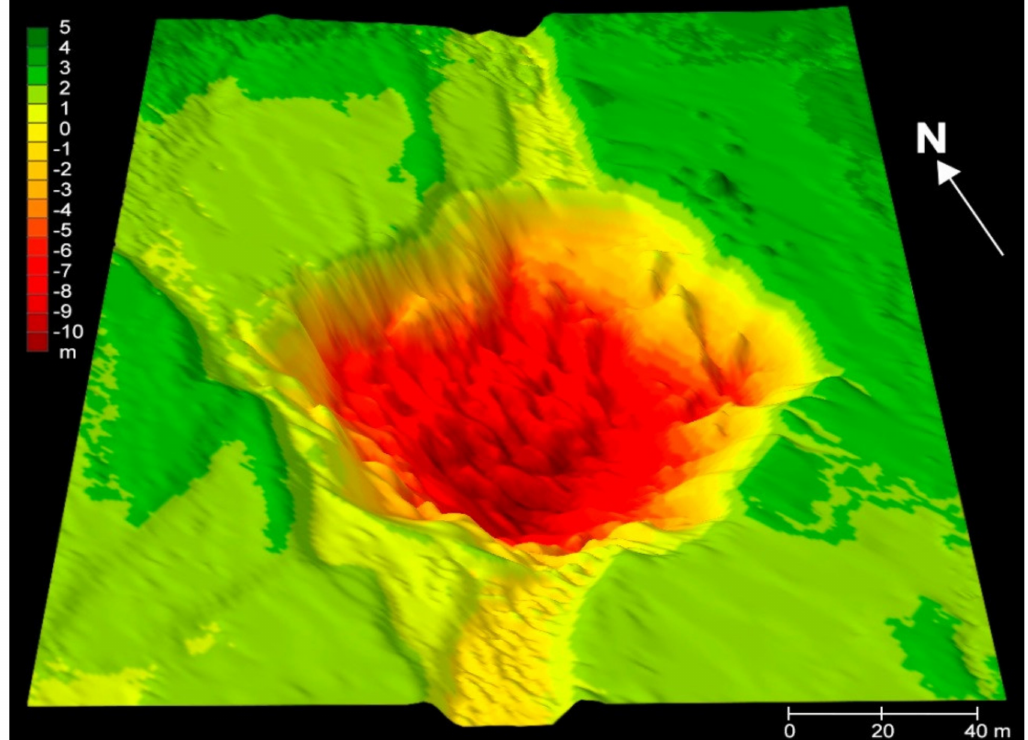
Figure 9. 3D DEM of the Seyakha gas blowout crater and surrounding area based on the data complex of aerial photography from the drone and the echo sounding survey (20 August